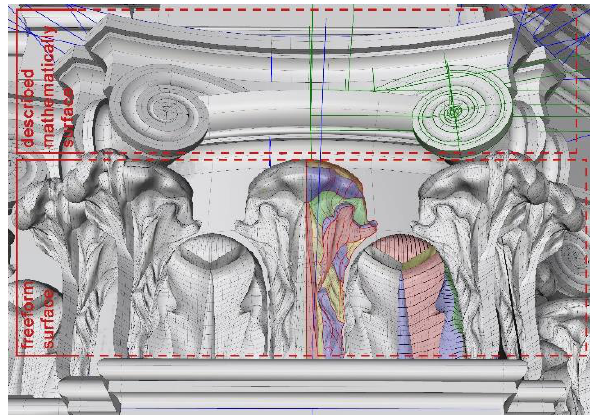
Figure 7. Construction of the surfaces of the Ionic and Corinthian parts of the capital with the different approaches and methods.